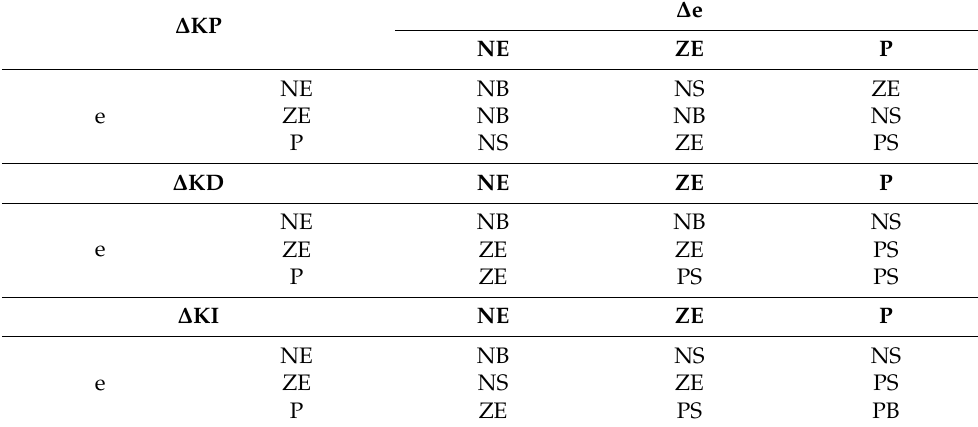
Table 2. Fuzzy linguistic rule-base.